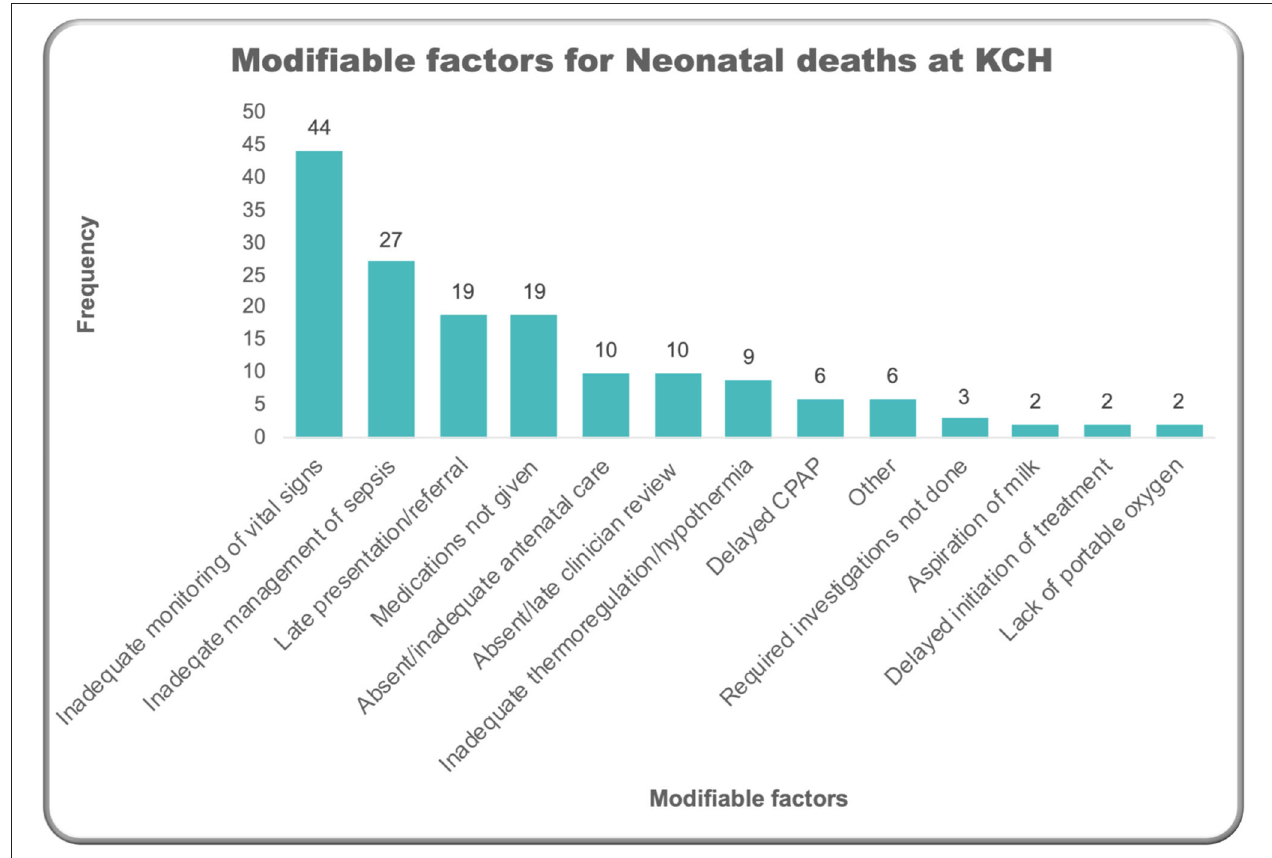
FIGURE 7 | Modifiable factors around